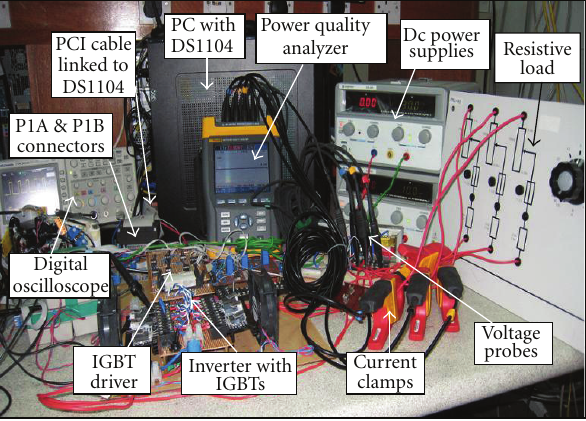
Figure 6: In lab experimental set up of the PV based inverter.